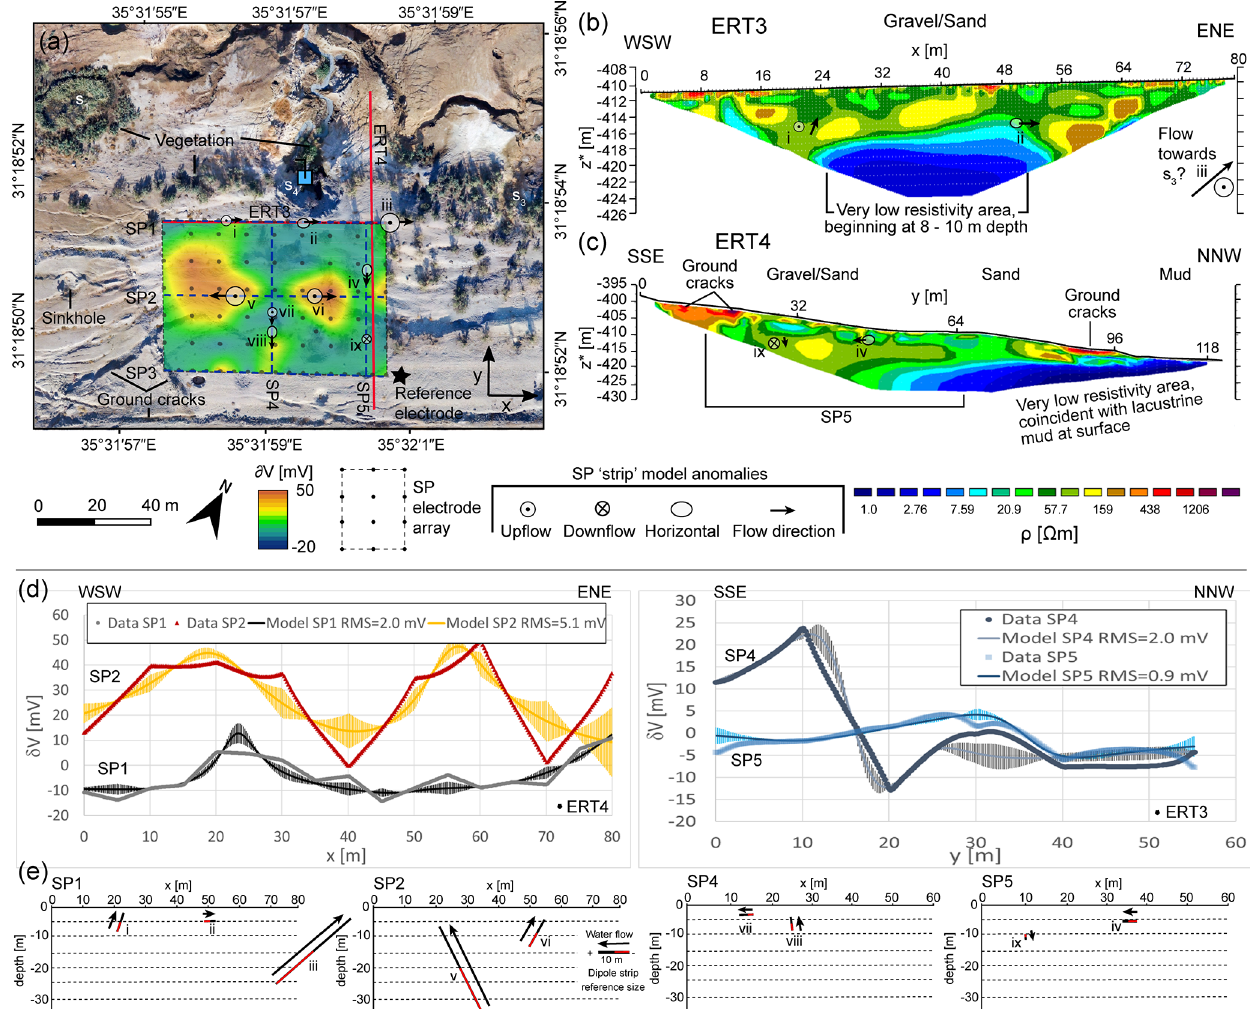
Figure 9. Summary of SP and ERT survey results at the head of CM5. (a) Map showing the arrangement of the SP electrodes in an array and the resulting heatmap of potentials (with reference to a fixed electrode at the south-eastern side of the array) overlain on an orthophoto from December 2016. The locations of the inverted profiles SP1–SP5 and their associated strip model anomalies are labelled, along with the modelled flow directions for the anomalies. Also marked are the locations of springs s 1 , s 3 , and s 4 . (b) Electric resistivity distribution along ERT profile 3, which used a Wenner configuration with an electrode spacing of 1m. Data inversion gave an rms error of 4.4% after eight iterations. The observed surface material and the locations and flow directions of SP strip anomalies are labelled. (c) ERT profile 4, which used a Wenner configuration with an electrode spacing of 2m. Data inversion gave an rms of 10% after five iterations. The observed surface material and the locations and flow directions of SP strip anomalies are labelled. (d) SP lines 1, 2, 4 and 5 data and derived best inversion model results with an indication of rms error. (e) Graphical representation of polarized strip anomalies matching the modelled SP line data. The direction of water flow along a strip to produce the inverted anomalies is generally from minus (red) to plus (black). Due to noise in the data, the exact peaks in the modelled self-potential curves are not always reached. All results from inversion of SP3 have been omitted from all figures for clarity; to see these results, see Fig. A2 in Appendix